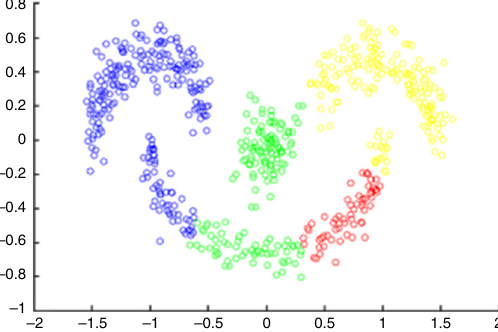
Figure 6. Result of complete- link on “ Smileface ” data set